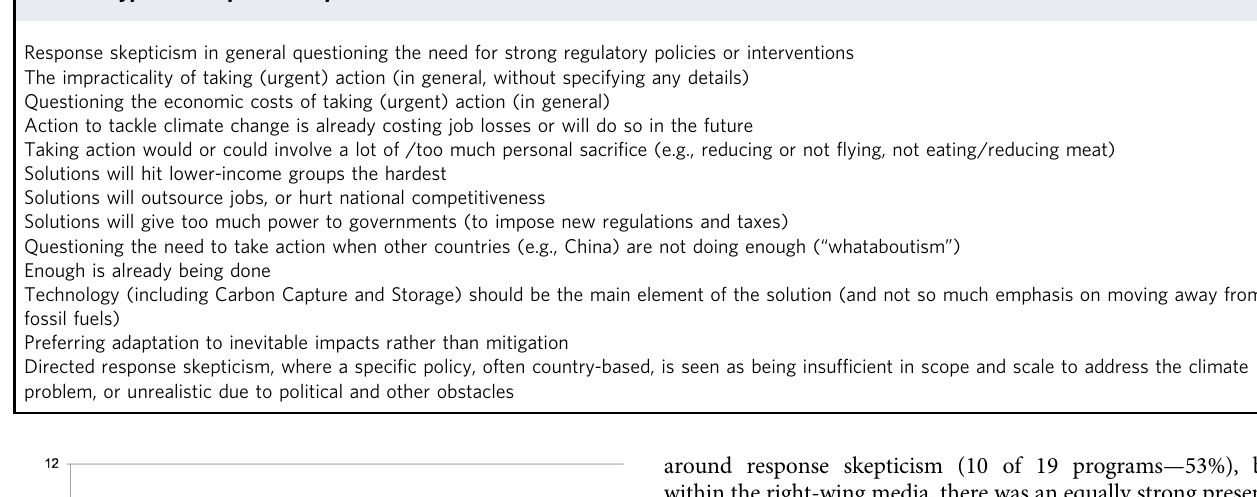
Table 3 Types of response skepticism.